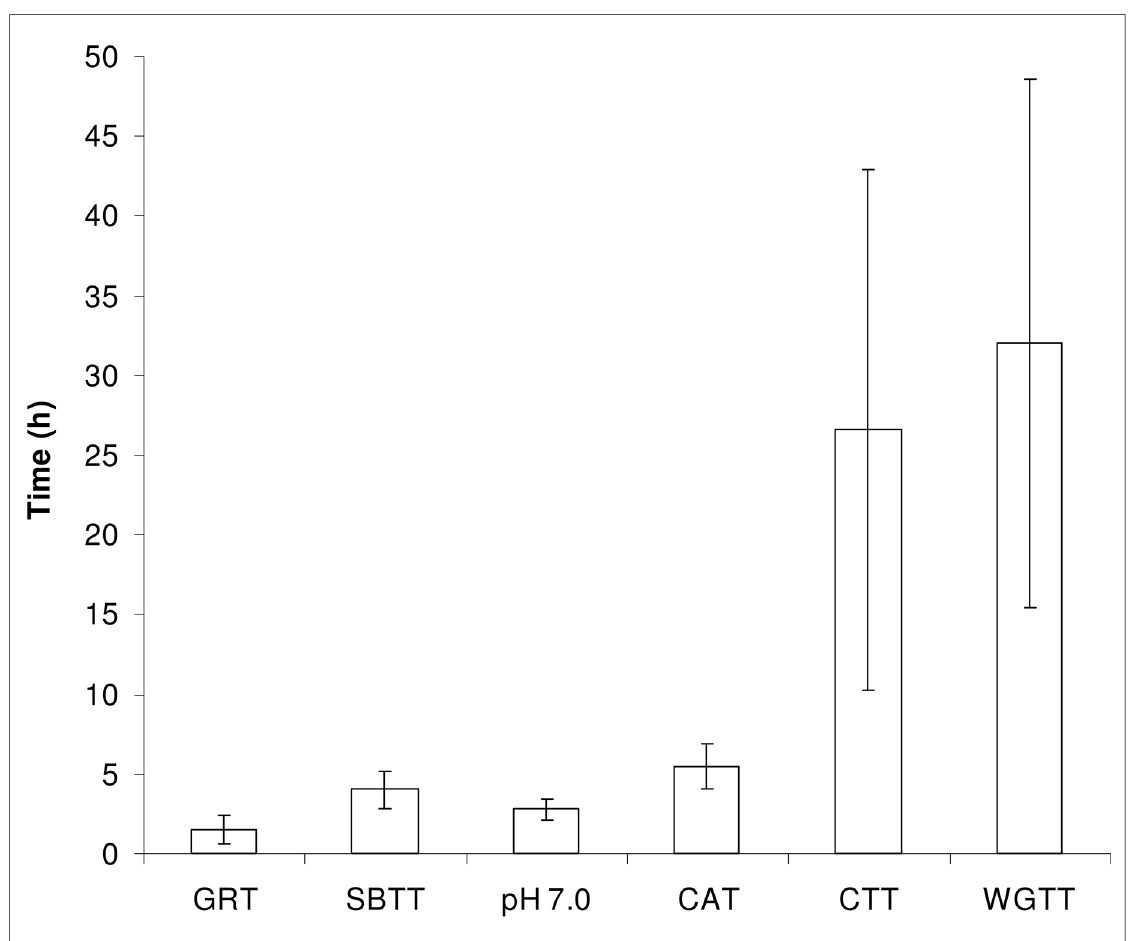
Fig 2. Mean (gastrointestinal residence and transit times determined with the IntelliCap system. Data are presented mean and standard deviation of 13 evaluable subjects (for CTT and WGTT n = 9).